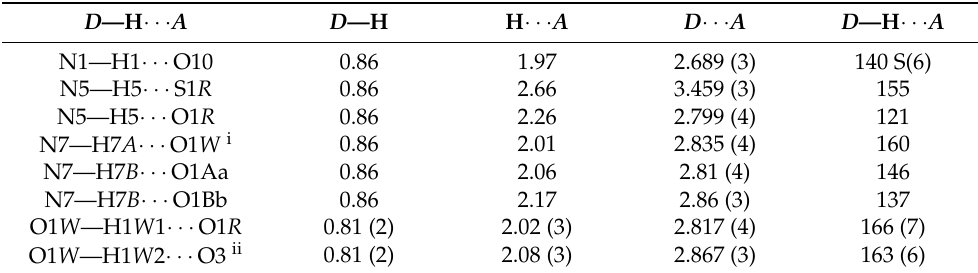
Table 3. Hydrogen-bond geometry (Å, ◦ ) for 2